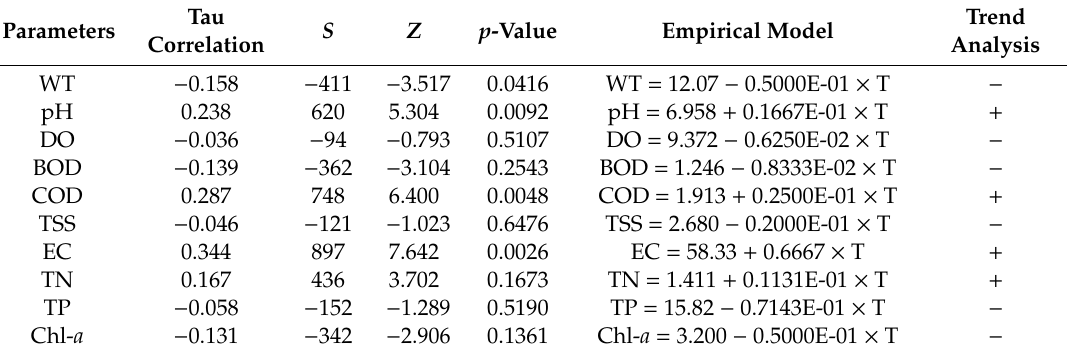
Table 3. Seasonal Mann–Kendal trend analyses in Soyang reservoir during 1992–2013.